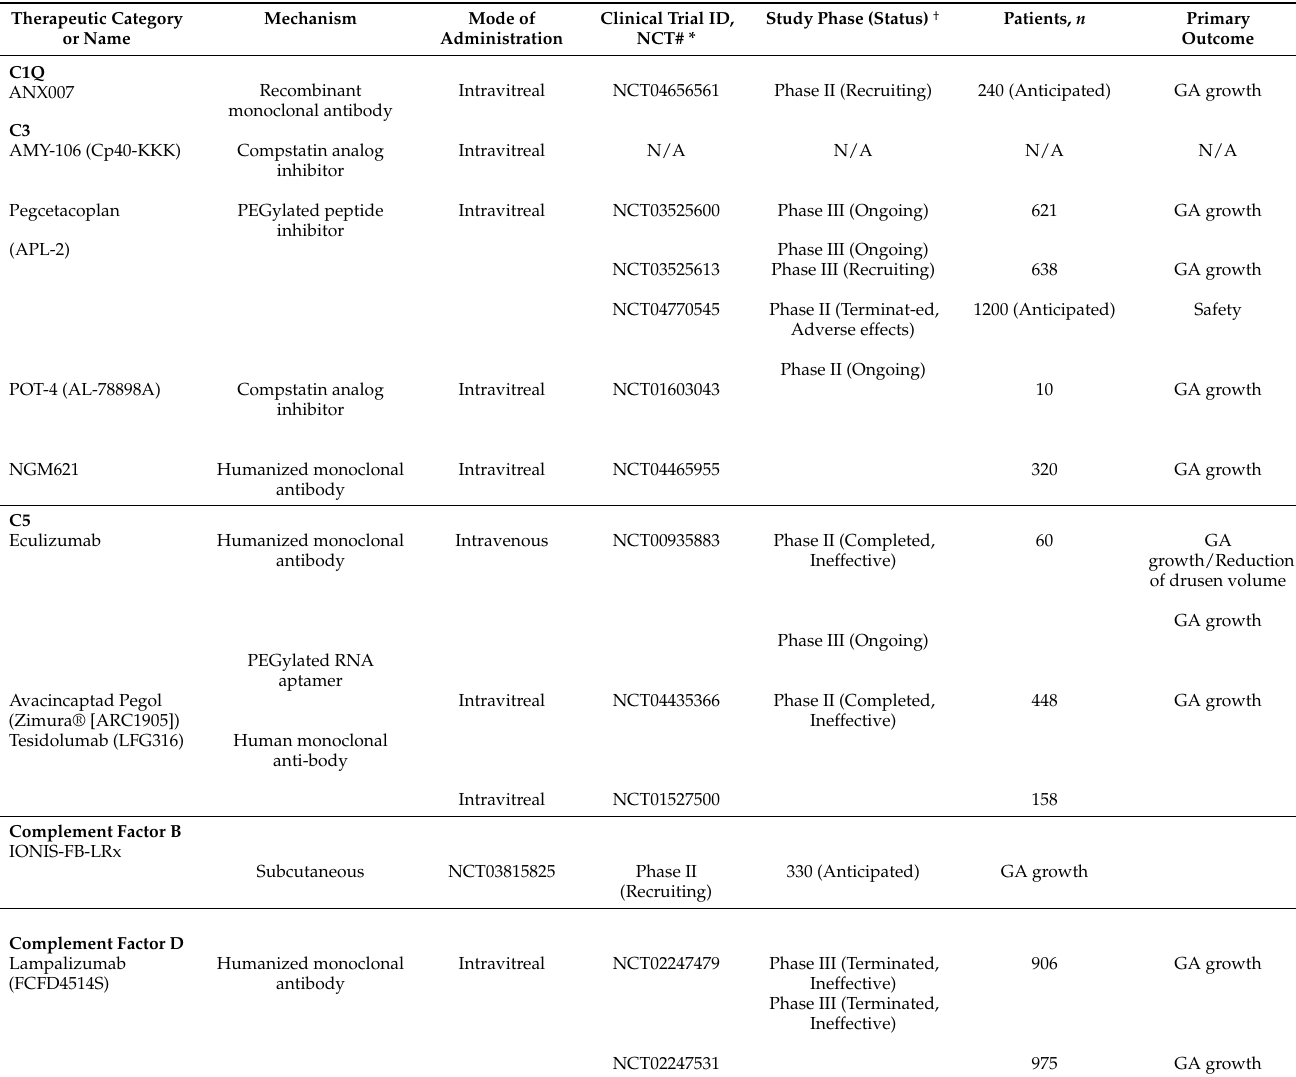
Table 1. Completed and current investigational treatments targeting the complement cascade in dry age-related macular